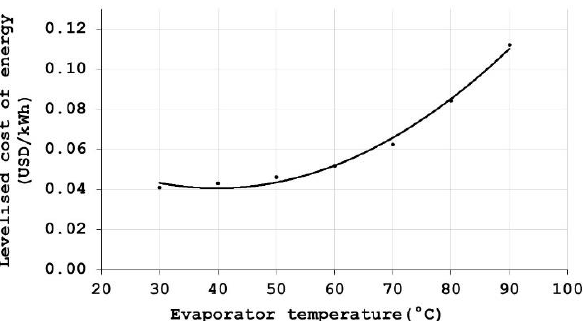
Figure 6. Levelized cost of energy regards different operating temperatures of the evaporator (case study 2).